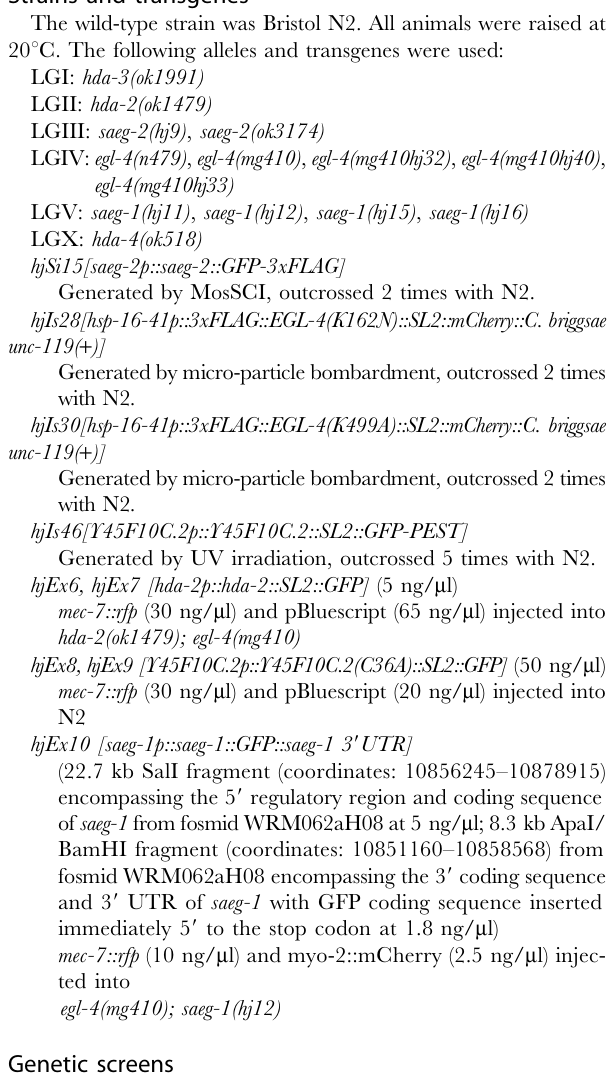
Figure 4. HDA-2 is part of the SAEG-1/SAEG-2 complex that mediates EGL-4 activity. (A) MudPIT analysis on proteins co- immunoprecipitated with FLAG-tagged Dnttip1 or ZNF541 from HEK293 cells. dNASF (distributed normalized spectral abundance factors) indicates the relative abundance of proteins. Results are from 3 independent biological samples. (Mean 6 SD). (B) Co-immunoprecipitation of FLAG-tagged HDAC1 with HA-tagged ZNF541 or Dnttip1 after co-expression in HEK293 cells. (C) Co-immunoprecipitation of FLAG-tagged HDA-2 with HA-tagged SAEG-2 after co-expression in Drosophila S2 cells. (D) Representative images of bacterial lawns on which a single animal was placed for 18 hours at 20 u C. Areas covered by worm tracks (enclosed by a white line) were measured as an indicator of foraging behavior of individual animals. Excessive dwelling behavior by egl-4(gf) animals resulted in the smallest area in which worm tracks were found. (E) Quantitation of bacterial lawn area that was explored by individual animals of indicated genotypes. Number of animals tested: n=60 (wild type and egl-4(gf) ); n=30 (all other genotypes). (Mean 6 SD; pair-wise t-test, *, p , 0.05 )